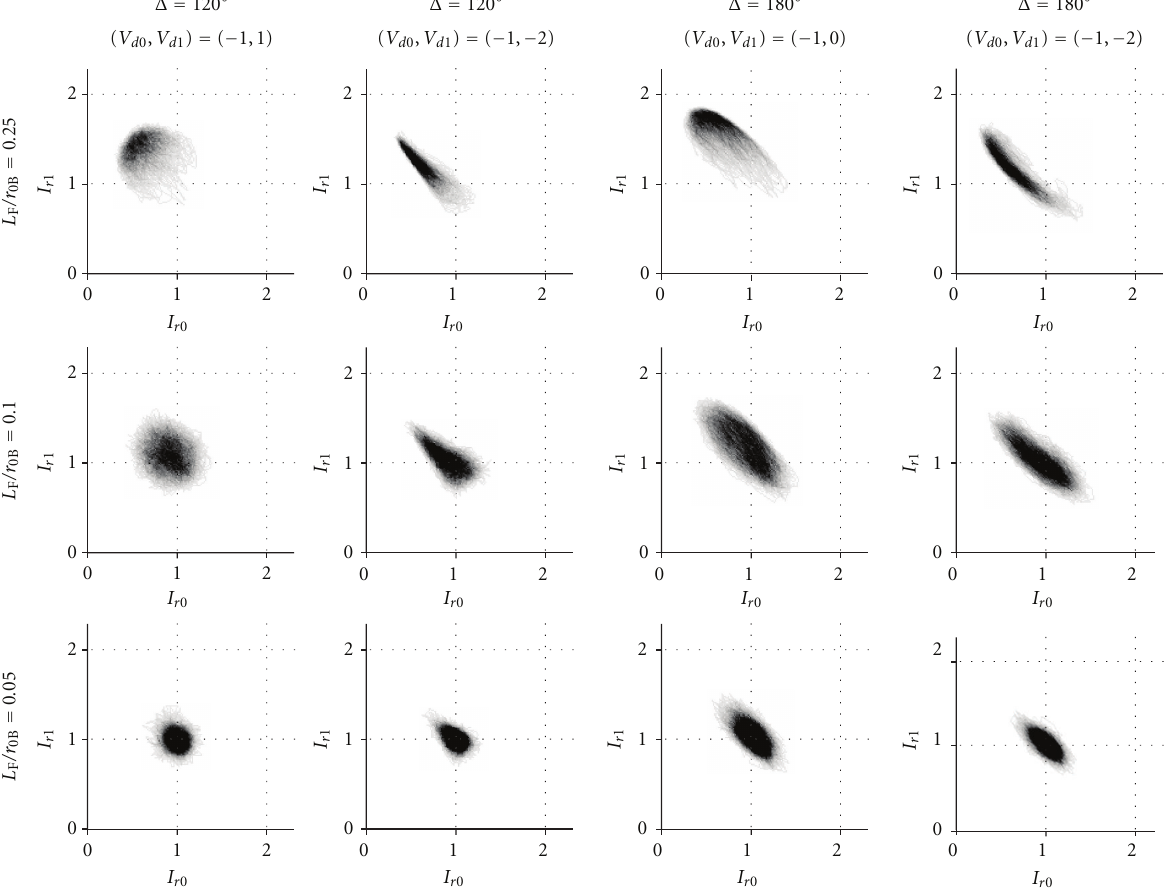
Figure 10: Two-dimensional probability density ρ ( I r 0 , I r 1 ) obtained with S hx ≈ 0 . 314 r 0 B , M outer = 5 r 0 B , and di ff erent values of V d 0 , V d 1 , L F , and Δ